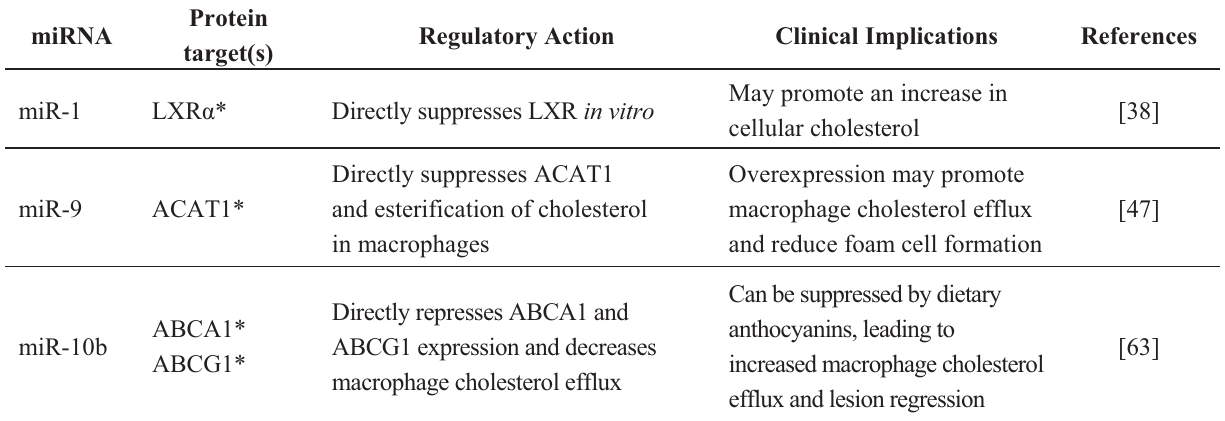
Table 1. Regulatory Actions of miRNAs and their Clinical